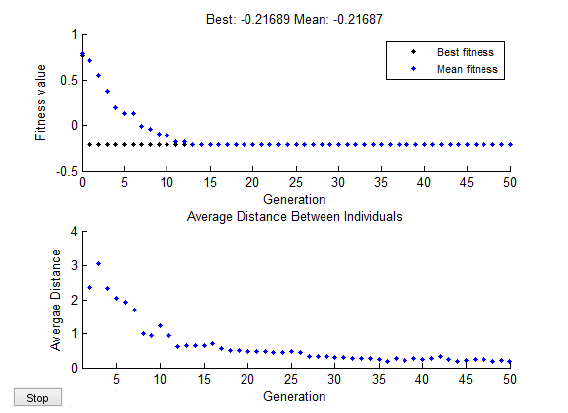
Fig. 12. Best fitness value for :; circular trajectory and average distance between individuals.